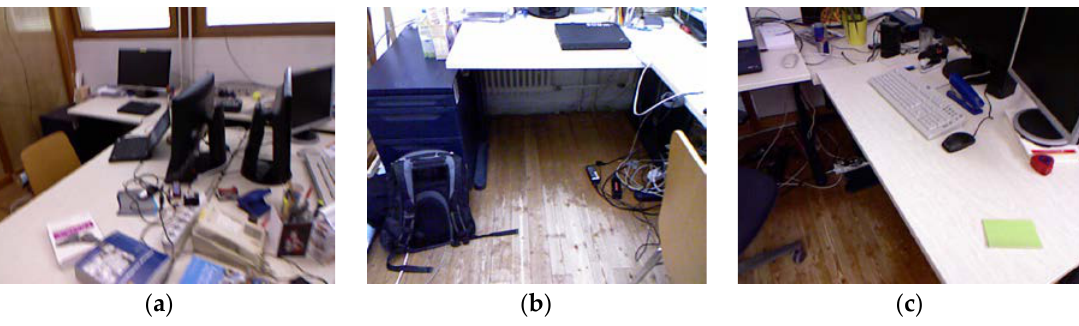
Figure 4. Part of the scene in fr1_room.